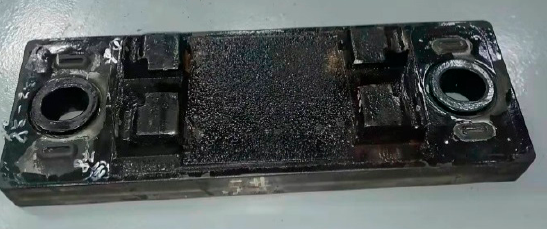
Figure 1. Elastic iron tie plate.